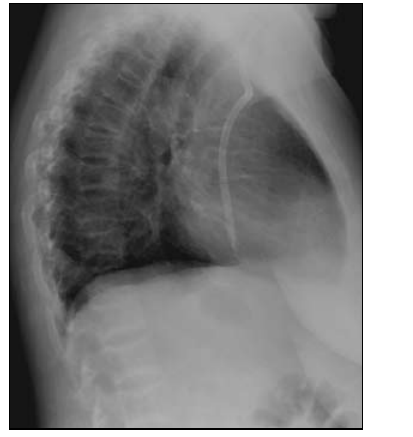
Fig. 1. Lateral chest radiograph. Fig. 2. Antero-posterior view of the right